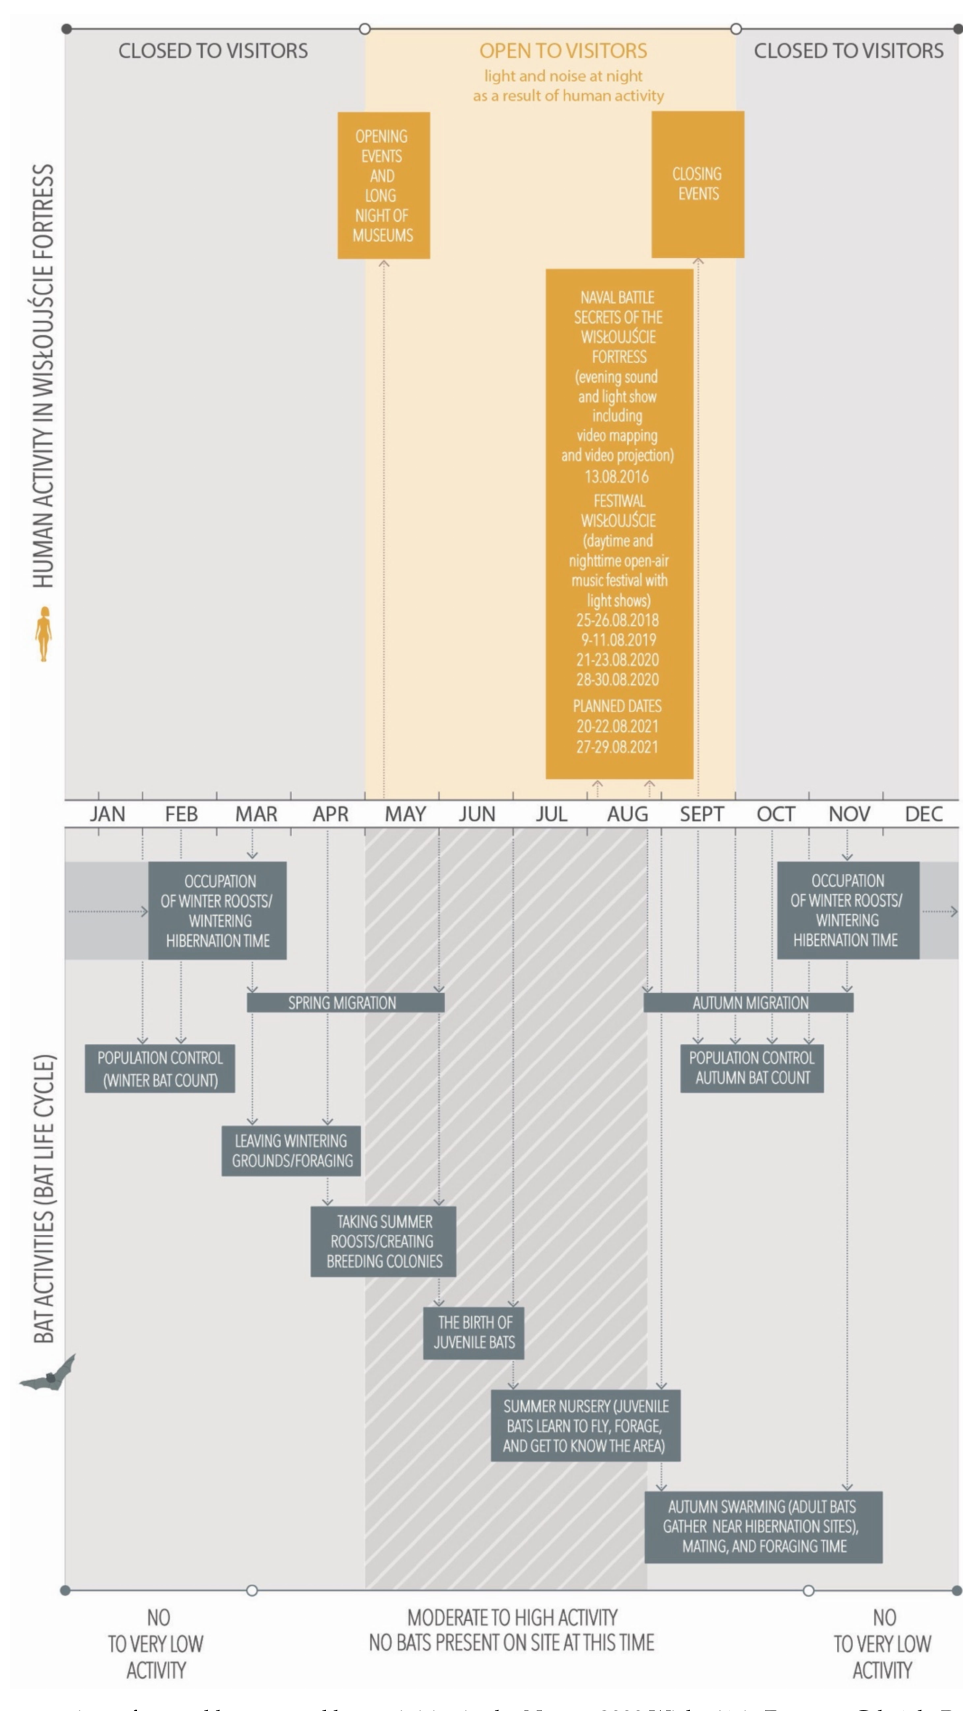
Figure 1. An overview of annual human and bat activities in the Natura 2000 Wisłouj´scie Fortress, Gda´nsk, Poland. Source: authors’ elaboration based on